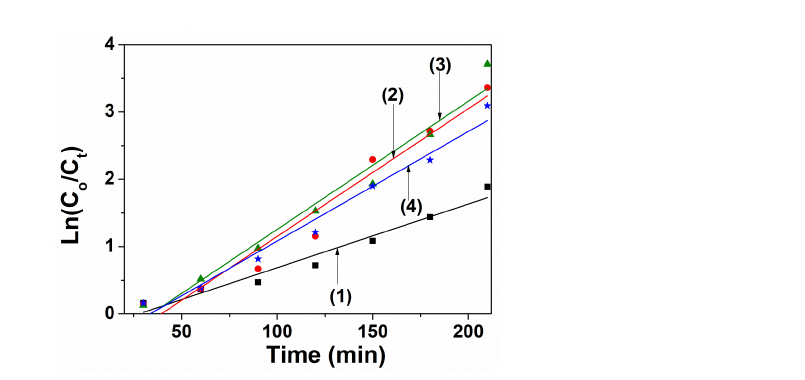
Figure 9. The plots of ln( C o /C t ) versus irradiation time ( t ) in the presence of H 2 O 2 and ZnNd x Fe 2−x O 4 nanoparticles: (1) x = 0, (2) x = 0.01, (3) x = 0.03, (4) x = 0.05. Table 2. The degradation efficiency (H%) and pseudo first-order rate constant (k) for the photocatalytic degradation of RhB in the presence of H 2 O 2 0.04 M using ZnNd x Fe 2−x O 4 nanoparticles. Samples H(%) k (min −1 ) R 2 ZnFe 2 O 4 85.14 ± 0.99 0.0095 0.952 ZnNd 0.01 Fe 1.99 O 4 96.53 ± 0.95 ZnNd 0.05 Fe 1.95 O 4 95.46 ± 0.91